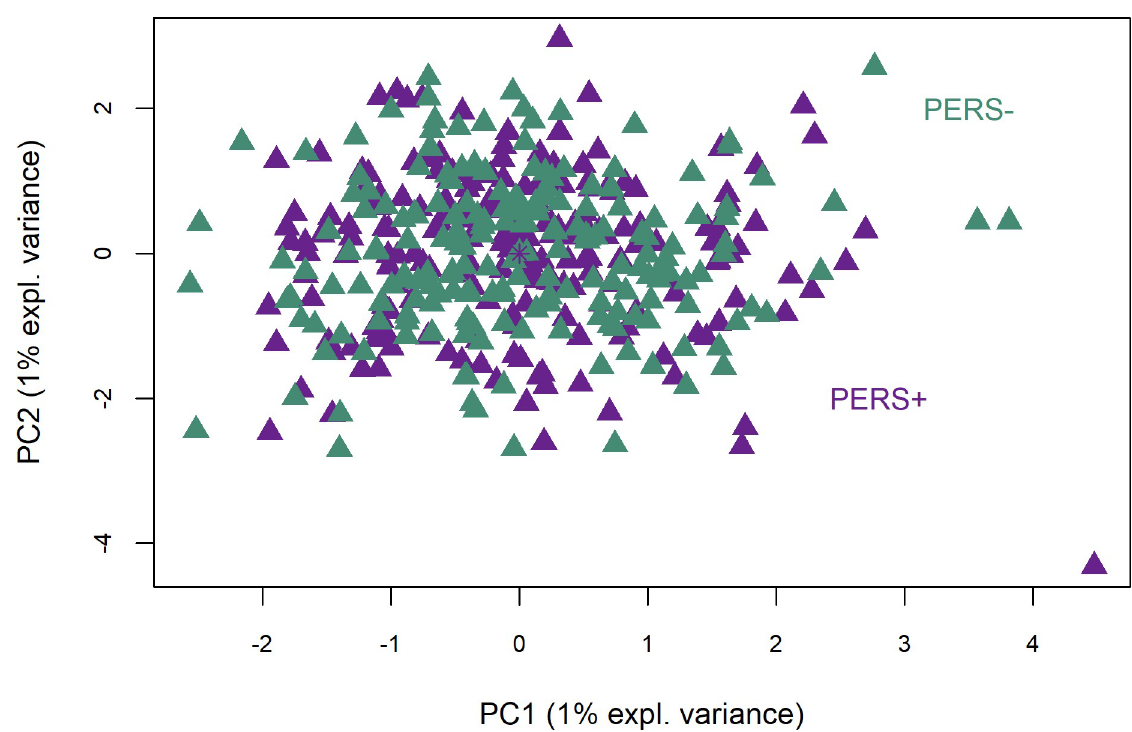
Fig 3. Sparse partial least squares discriminant analysis between divergent milk persistency (PERS) lines. PERS+: ewes selected for a high milk persistence; PERS-: ewes selected for a low milk persistence.